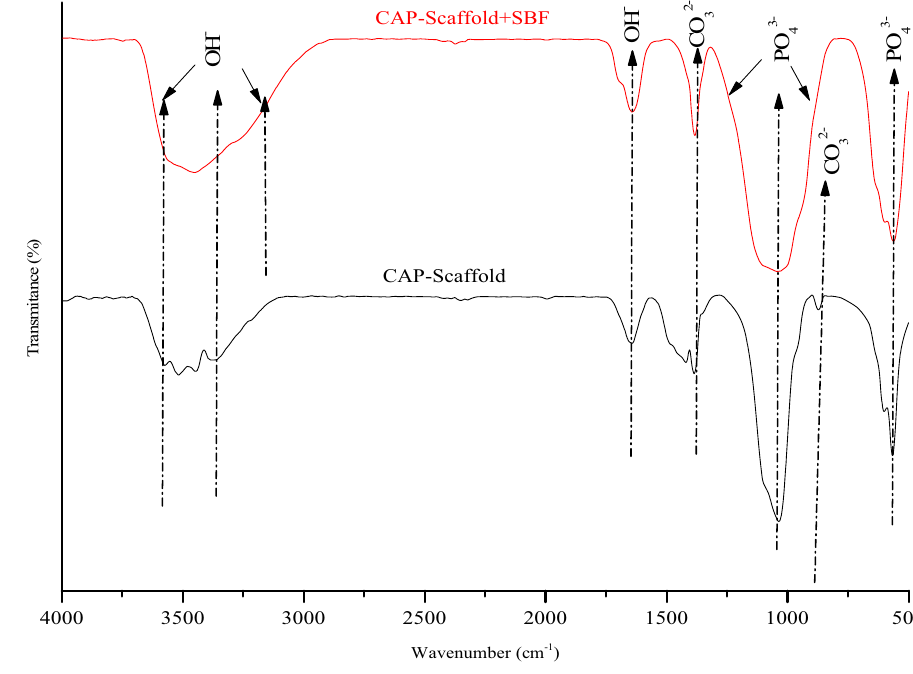
Fig. 14 FT-IR spectra of CAP- AMB scaffold before and after immersion in SBF solution for 7 days at pH of 7.4 and tem- perature of 37